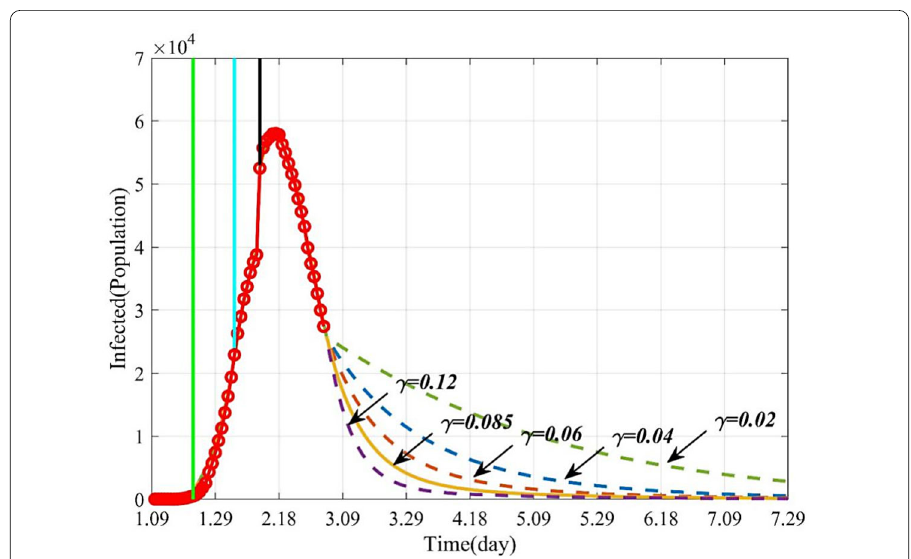
Figure 8 Dynamic trends of the infected with different removal rates ( γ ). The solid line represents the trends of the infected with the current γ . The purple dotted line represents the trends of the infected when γ = 0.12. The orange dotted line represents the trends of the infected when γ = 0.06. The blue dotted line represents the trends of the infected when γ = 0.04. The green dotted line represents the trends of the infected when γ =